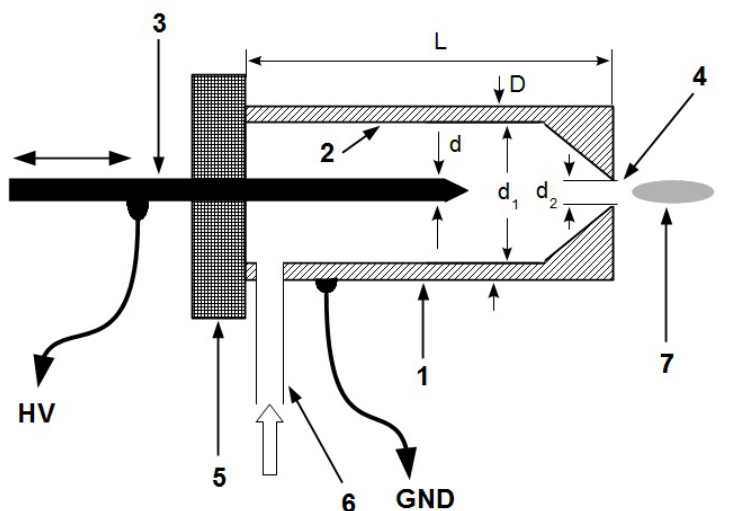
Figure 1. Mechanical layout of the plasma source (not to scale). 1-aluminum block; 2-cylindrical cav- ity; 3-brass rod; 4-plasma output hole; 5-teflon insulating disk; 6-carrier gas input duct; 7-plasma